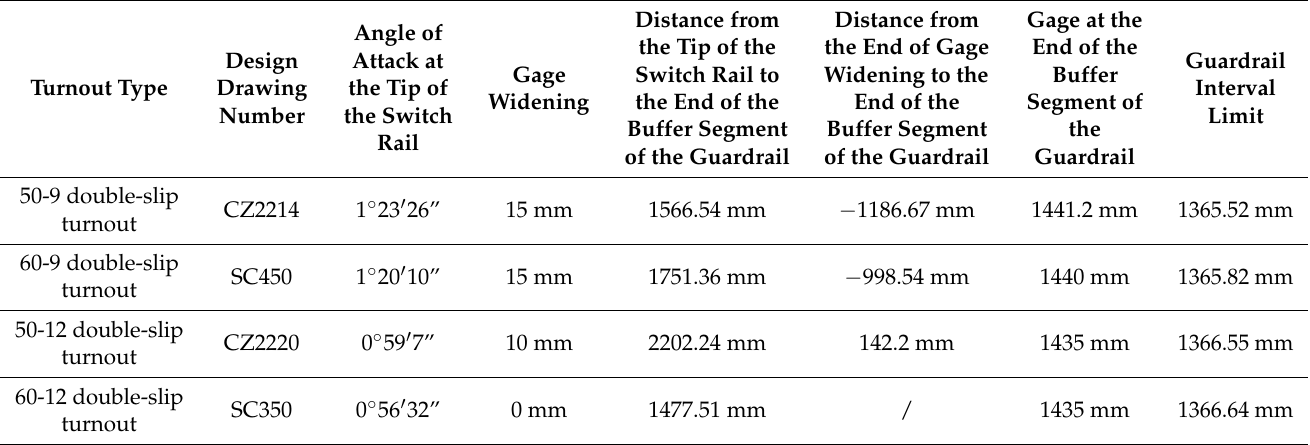
Table 2. Alignment parameters and guardrail interval limits of the main double-slip turnout